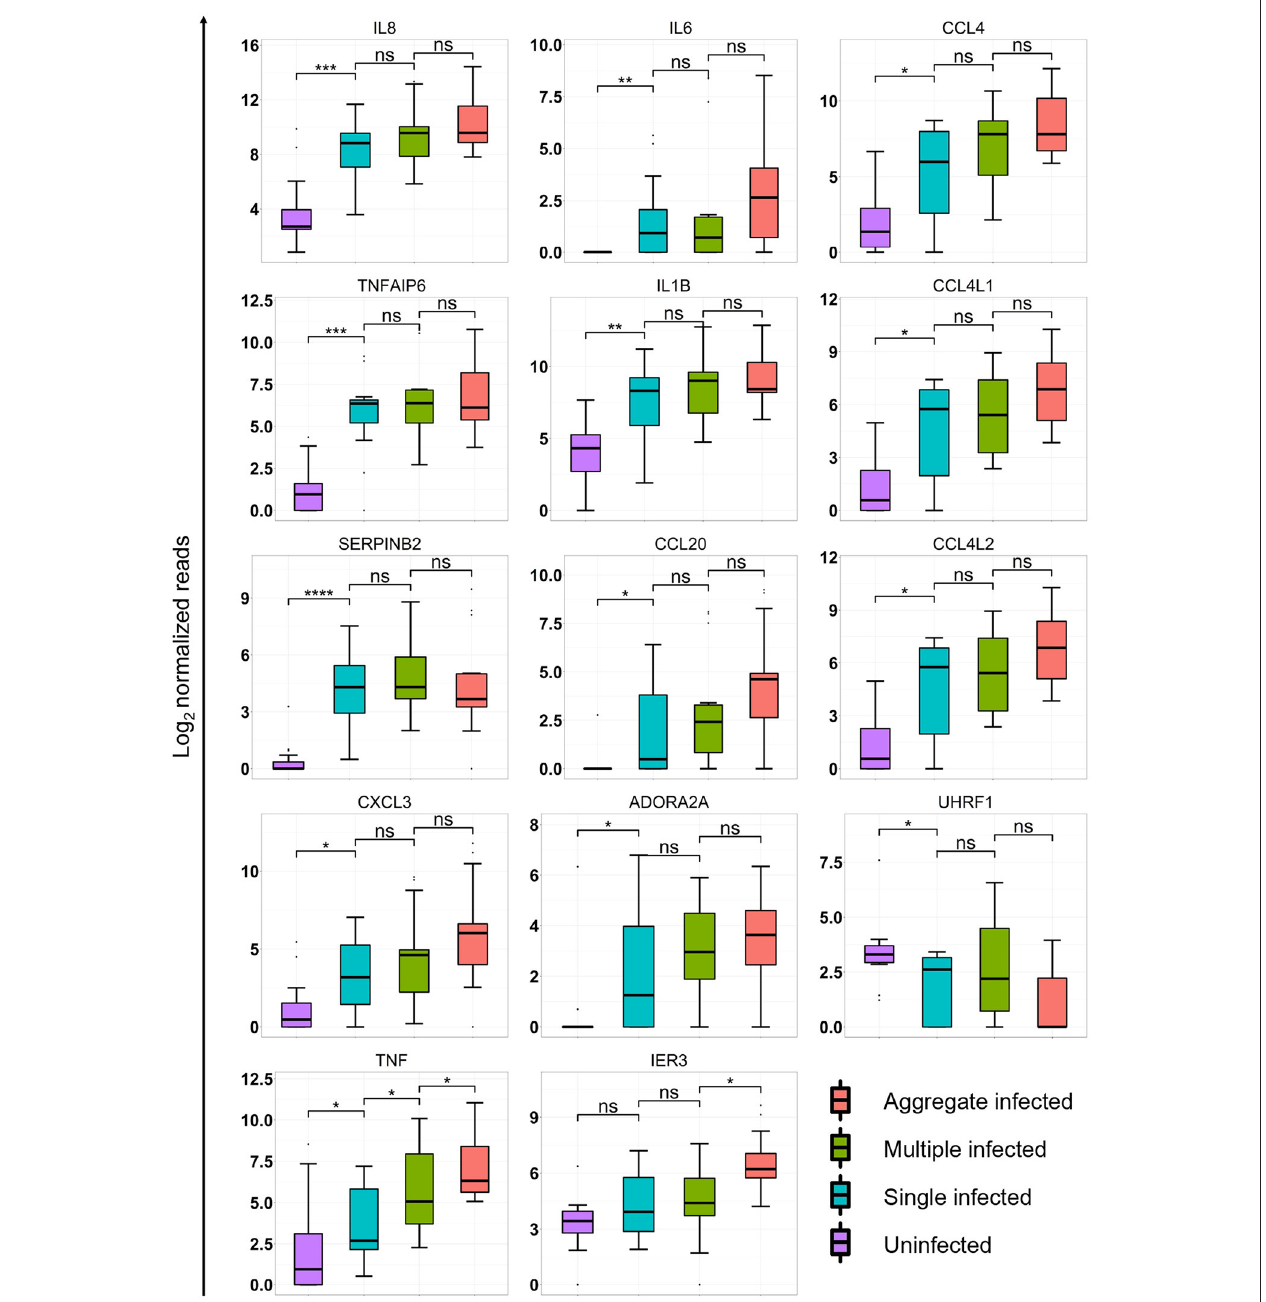
FIGURE 3 | Aggregation state alters macrophage transcriptional response at the single gene level. Box plots of median and interquartile range of log normalized read counts from 15 independent infections of monocyte-derived macrophage (MDM) from 5 blood donors. Shown are expression levels as log transformed read counts in uninfected, single infected, multiple infected and aggregate infected macrophages. p-values are ns = not significant; * < 0.01; ** < 0.001; *** < 0.0001; **** < 0.00001; as determined by Kruskal–Wallace non-parametric test with Hochberg multiple comparison correction, with comparisons performed to nearest neighbor in graph (3 comparisons